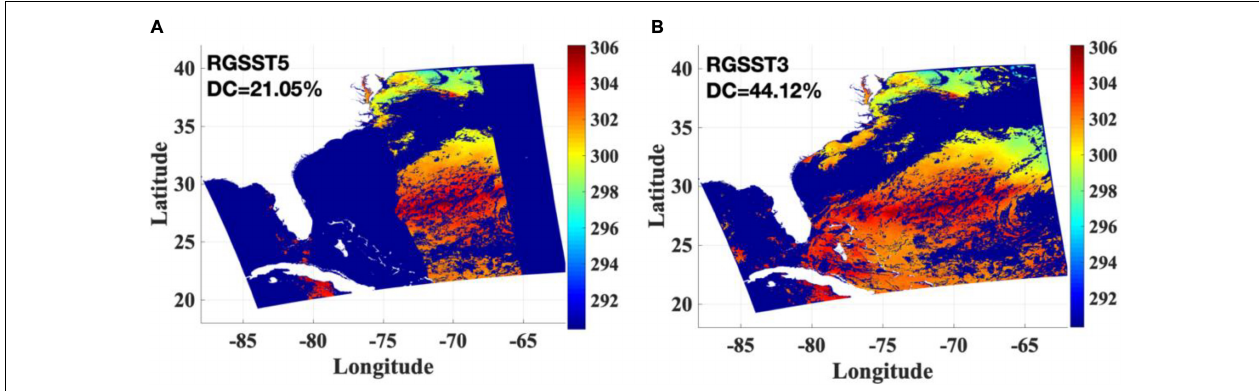
FIGURE 2 | Regression-based SST maps for the same granule of Figure 1 , obtained from PO.DAAC website: (A) RGSST5 at QF = 5 and (B) RGSST3 at QF ≥ 3. DC stands for data coverage. The ranges of longitude and latitude from − 180 ◦ to 180 ◦ and from − 90 ◦ to 90 ◦ represent West to East and South to North, respectively. Unit of color bar is